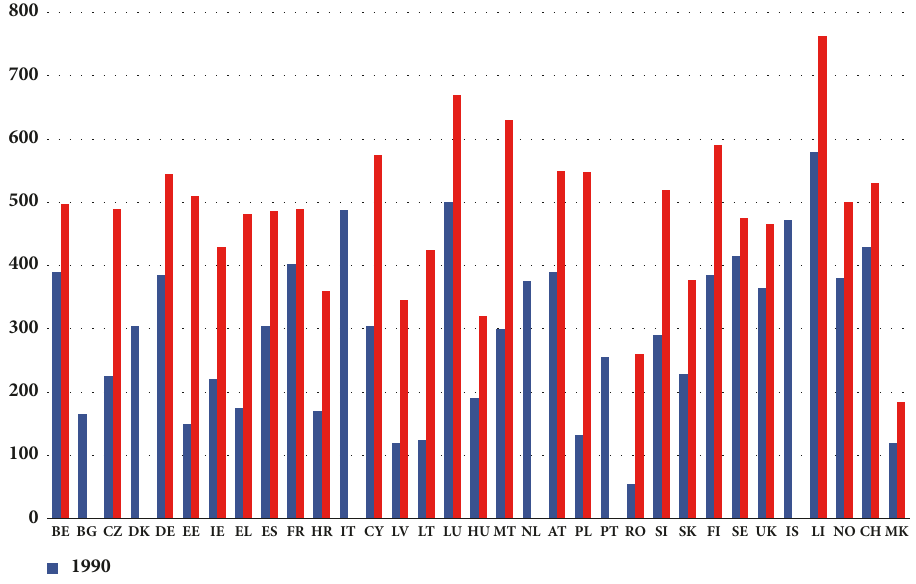
Figure 1: The increase in the number of passenger vehicles per 1000 inhabitants in EU